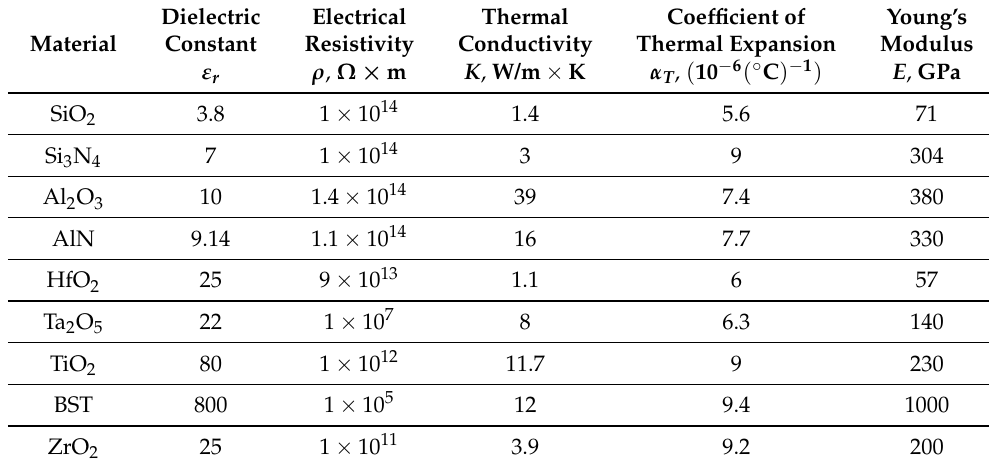
Table 4. The main parameters for choosing the material of the dielectric layer. Dielectric Electrical Thermal Coefficient of Young’s Material Constant Resistivity Conductivity Thermal Expansion Modulus ε